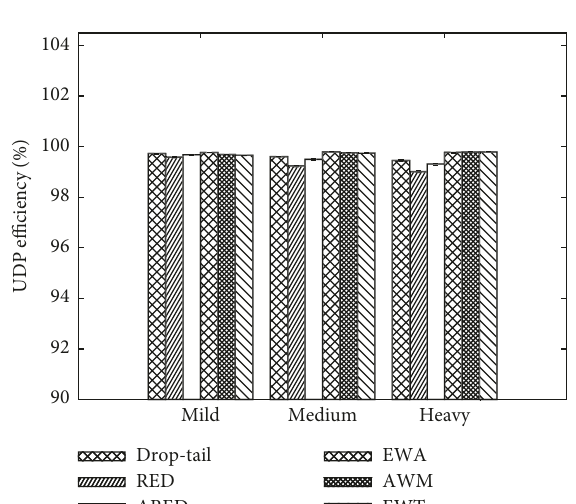
Figure 12: UDP efficiency: Scenario 2.